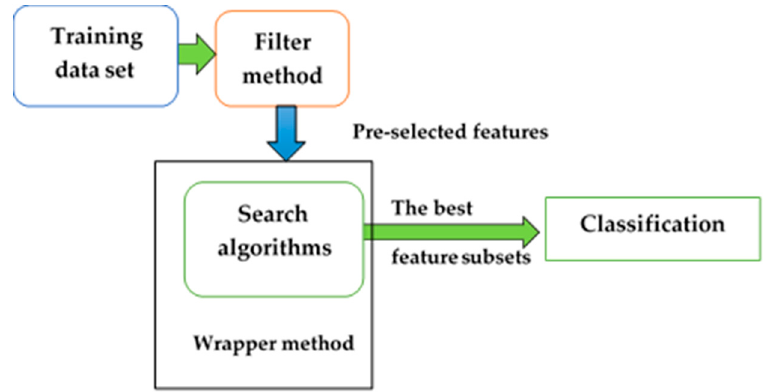
Figure 1. Hybrid feature selection method .